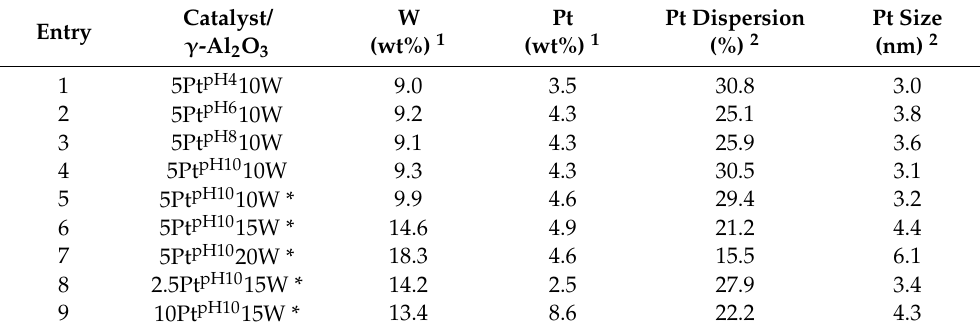
Table 1. Composition and dispersion data for different Pt-WO x /Al 2 O 3 catalysts.